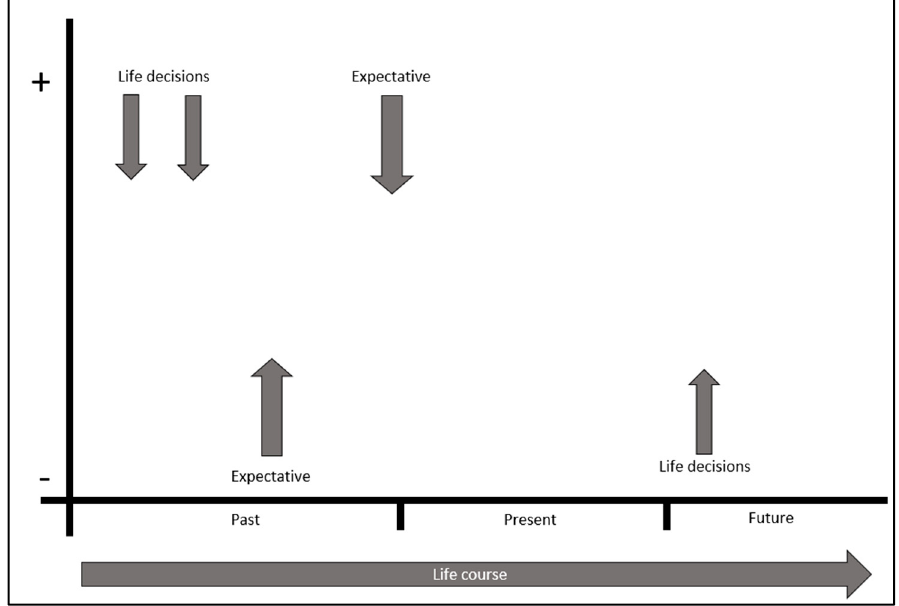
Figure 1. Biogram template used to point out the different decisions and expectations throughout respondents’ life paths.